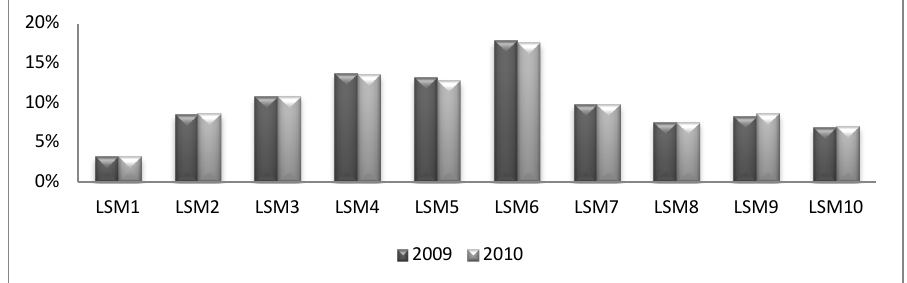
FIGURE 2: Cell C pre-paid customers by LSM group Source: Cell C